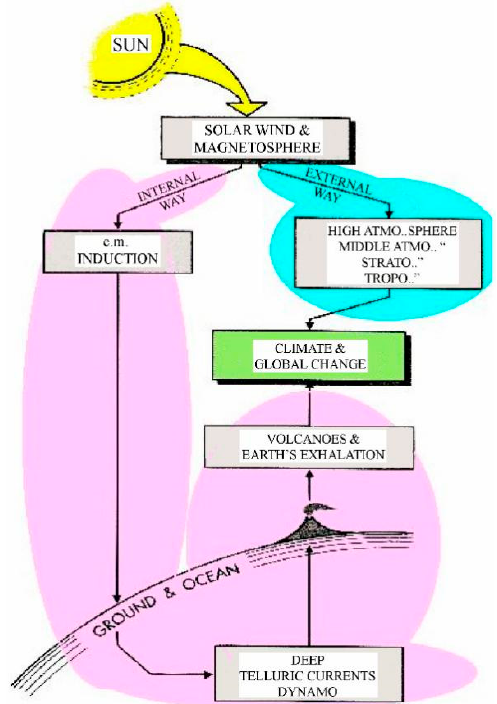
Figure 2. The ‘‘ external ’’ and ‘‘ internal ’’ way in solar–terrestrial relations. After Gregori (1997) [4]. Figure 2. The “ external ” and “ internal ” way in solar–terrestrial relations. After Gregori (1997) The timing of the battery discharge is explained by the fact that every electric circuit expands in space as much as possible (in college physics this is the Hamilton variation principle). That is, electric currents are generated inside deep Earth by the TD dynamo. Every circuit attempts to expand as much as possible, depending on the local electrical conductivity σ . Finally, currents decay by Joule heat wherever they find an almost step-like drop of σ . Every drop can be approximately denoted as a σ discontinuity. Step-like drops can indeed be monitored by means of the geomagnetic field (Gregori, 2002, 2009) [2,3]. A confirmation of this interpretation is provided by independent estimates, of the depth of these well-known step-like transitions inside deep Earth. A coincidence is thus verified of estimates by seismology and by geomagnetism. In addition, the secular variation of the geomagnetic field permits to detect the large changes vs. time of the radius of the Earth’s IC . This is the mechanism for the time-variation of the energy storage in the Earth battery. A surface of σ discontinuity is, however, not perfectly spherical. Thus, owing to Hamilton, every minor bump (Figure 3) of such a surface implies a larger concertation of electric current right at the very top of the bump, where Joule heat is generated. Thus, σ is locally increased and the σ discontinuity can expand. The process reminds us about an electric soldering iron that is pushed inside a block of ice ( ESI mechanism). Thus, a spike is generated, and the Earth’s interior finally reminds us about a sea-urchin. When a “spike” approaches the Earth’s surface, as soon as some fluids (water, oil, CH 4 , geogas, etc.) are available, fluids can transport heat by advection. However, when fluids are insufficient, the local temperature increases and the “spike” further propagates upward. When the spike reaches some shallow depth of a lower lithostatic pressure, where equation-of-state permits melting, a new fluid is formed, i.e., magma, which samples the basalt chemism of the layer where it is formed. Indeed, the isotopic chemism of ocean basalt is useful information suited to check the whole process. The magma is just another fluid that, through an eruption, transports heat by advection. The “sea-urchin spikes” have a twofold role: (i) they are effective channels for the energy transfer from deep Earth through Earth’s surface, and (ii) they are efficient antennae for the e.m. coupling between solar wind and deep Earth, thus permitting the modulation of the TD dynamo. In fact, in this way, the Faraday screening is avoided by shallow Earth’s layers. In addition, the mutual